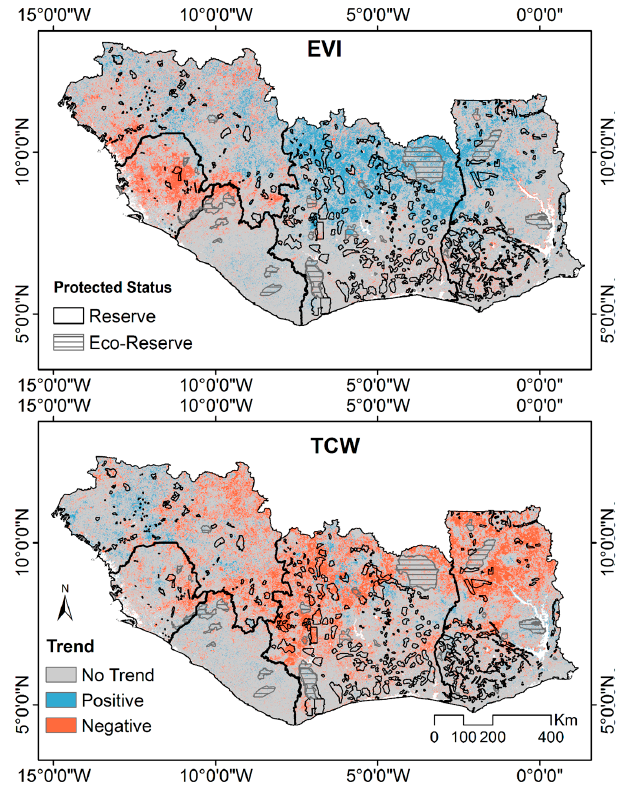
Figure 4. Residual trends for vegetation indices, after controlling for the effect of precipitation.